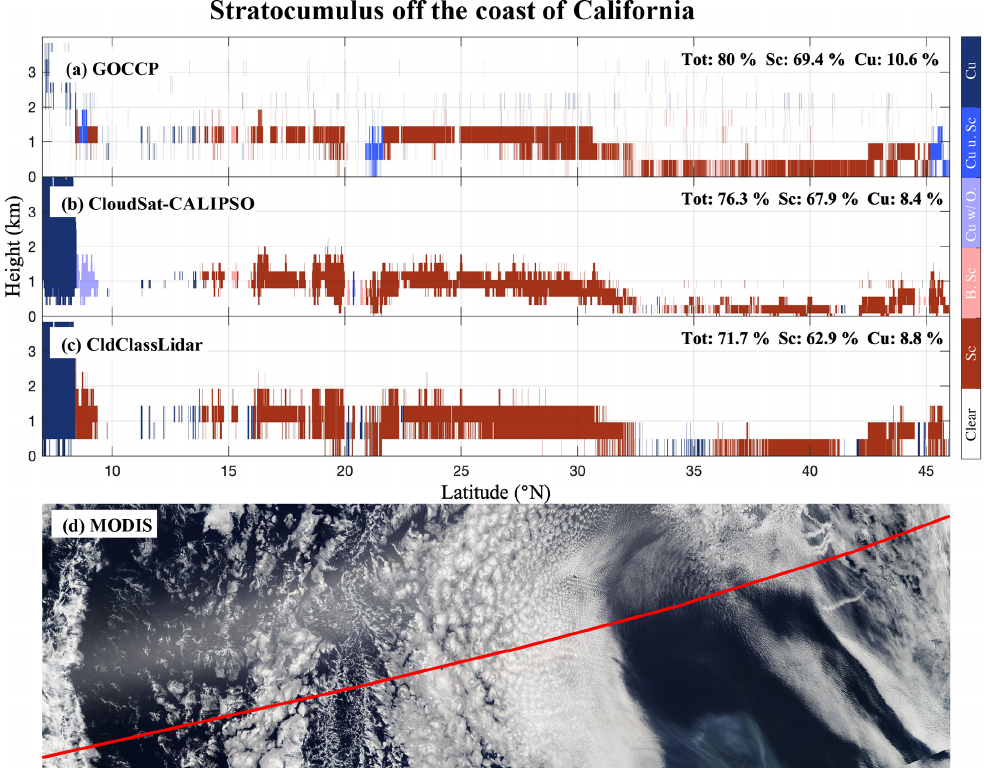
Figure 7. Same stratocumulus case study as in Fig. 5 but for (a) the standard GOCCP Sc–Cu mask (same as Fig. 5b), (b) the RL-GeoProf